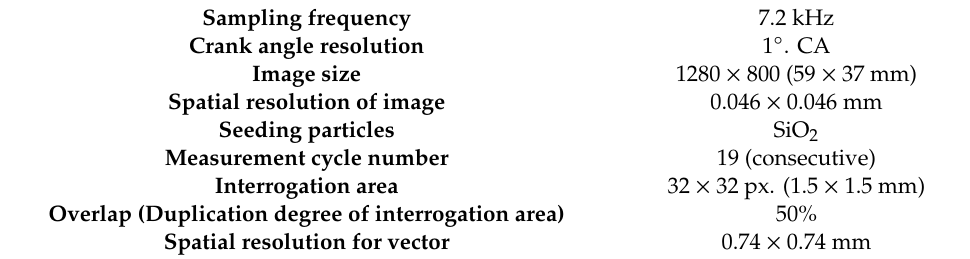
Table 2. PIV set up